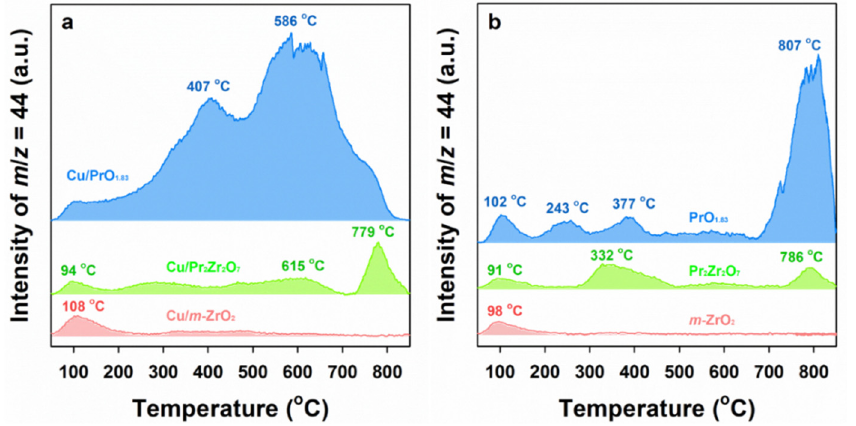
Figure 5. CO 2 temperature ‐ programmed desorption (TPD) profiles of ( a ) supported Cu catalysts and ( b ) support materials.